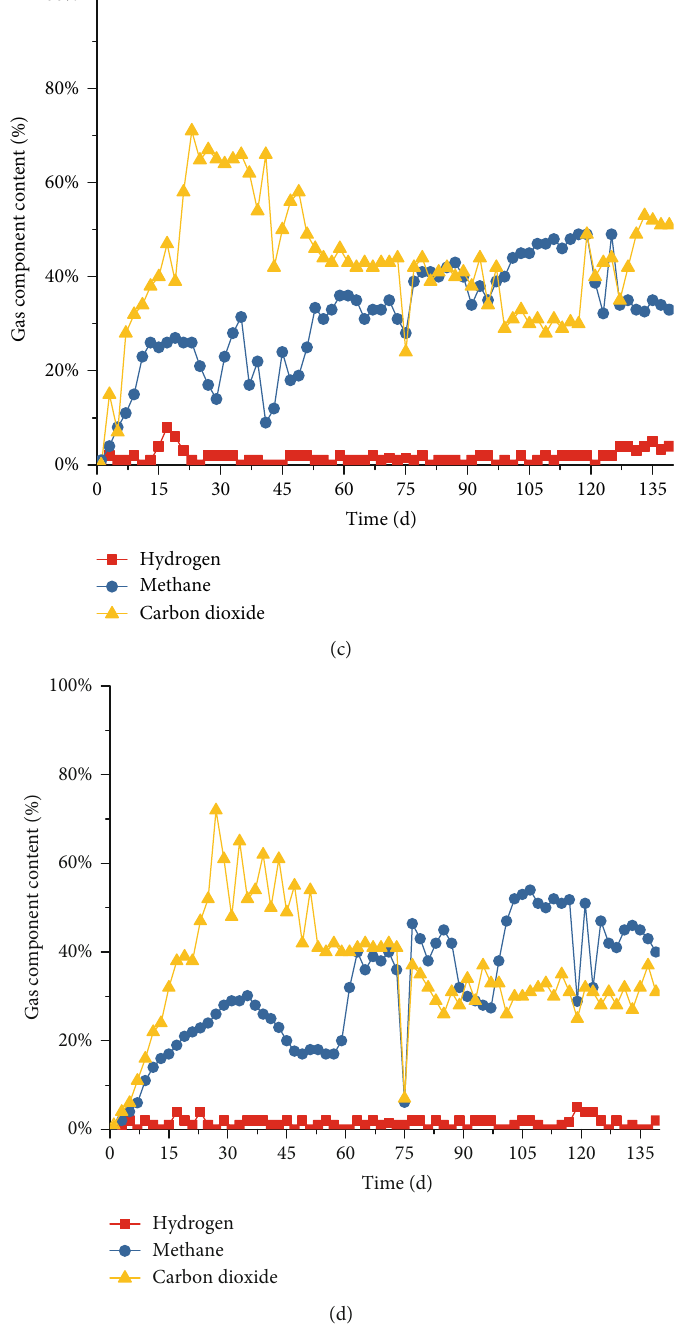
Figure 7: Variation in biogas concentration ((a) compartment 1; (b) compartment 2; (c) compartment 3; and (d) compartment